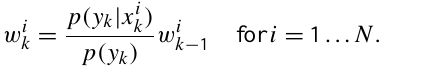
Fig. 4. Composite over 20 CT El Ni˜no events of the predictive power, PP(NINO3), gained by assimilating observations in JFM(0) for a given location (left panels); and the composite predictive power remaining in June (right panels). Assimilated quantities are a) the SST, b) the zonal wind speed or c) the thermocline depth.